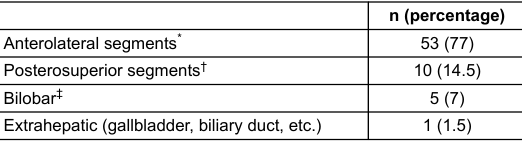
Table 4: Location of the lesions.